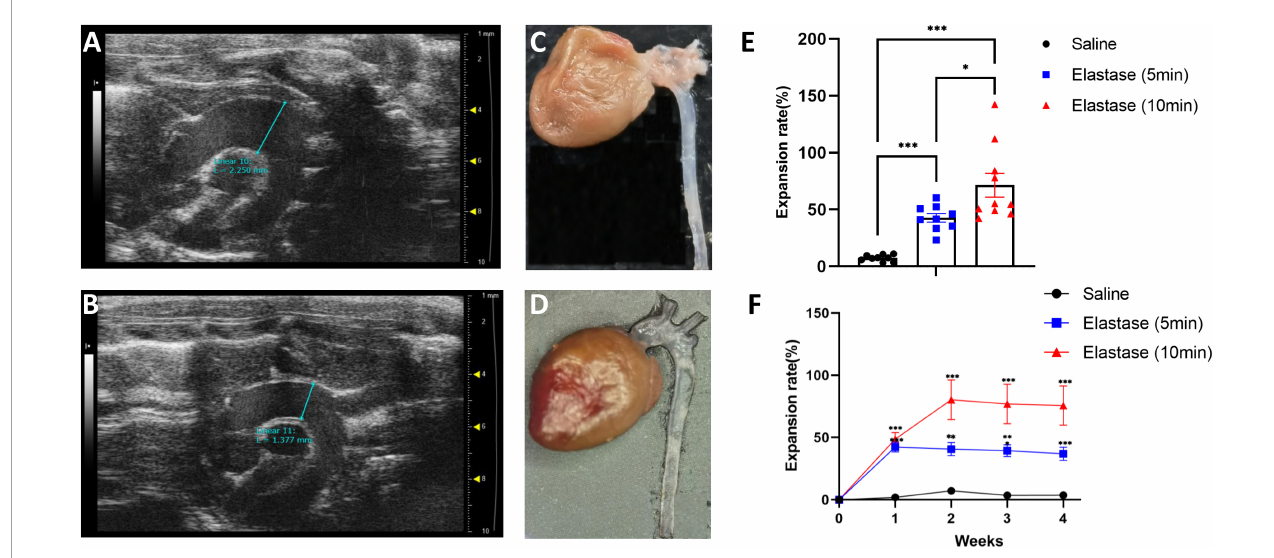
FIGURE2 The ultrasonic image, morphology, and the expansion rate of proximal thoracic aortic aneurysm (PTAA) models. (A) The representative ultrasonic image of the PTAA (5-min elastase application), the maximal ascending aorta diameter is 2.25 mm 28 days after operation. (B) The representative ultrasonic image of the controlled thoracic aorta, the maximal ascending diameter is 1.38 mm 28 days after operation. (C) Representative morphology of PTAA. (D) Representative morphology of the controlled thoracic aorta. (E) Fourteen days after operation, the aortic dilation rate in 5-min, 10-min elastase, and saline application groups. The aortic dilation rate in different groups were compared with the two-tailed Mann–Whitney tests, ∗ P < 0.05, ∗∗∗ P < 0.001. (F) Aortic dilation rate over time during PTAA formation. Maximal ascending aortic diameter (mean ± s.e.m.) in male C57BL/6J exposed to 5-min ( n = 9) or 10-min ( n = 9) elastase application or exposed to 10-min saline ( n = 9) over time. The aortic dilation rate between the 5-min or 10-min elastase application group and the saline group were compared with the two-tailed Mann–Whitney tests, ∗∗ P < 0.01, ∗∗∗ P <